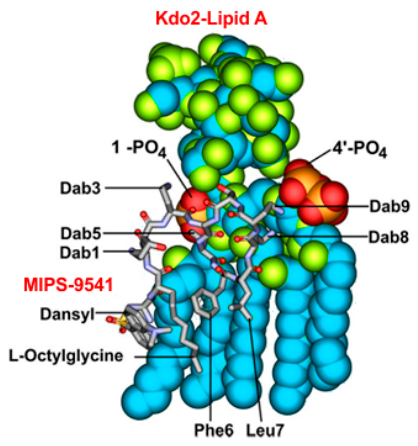
Figure 2. NMR derived model of MIPS-9541 in complex with bacterial Kdo2-lipid.